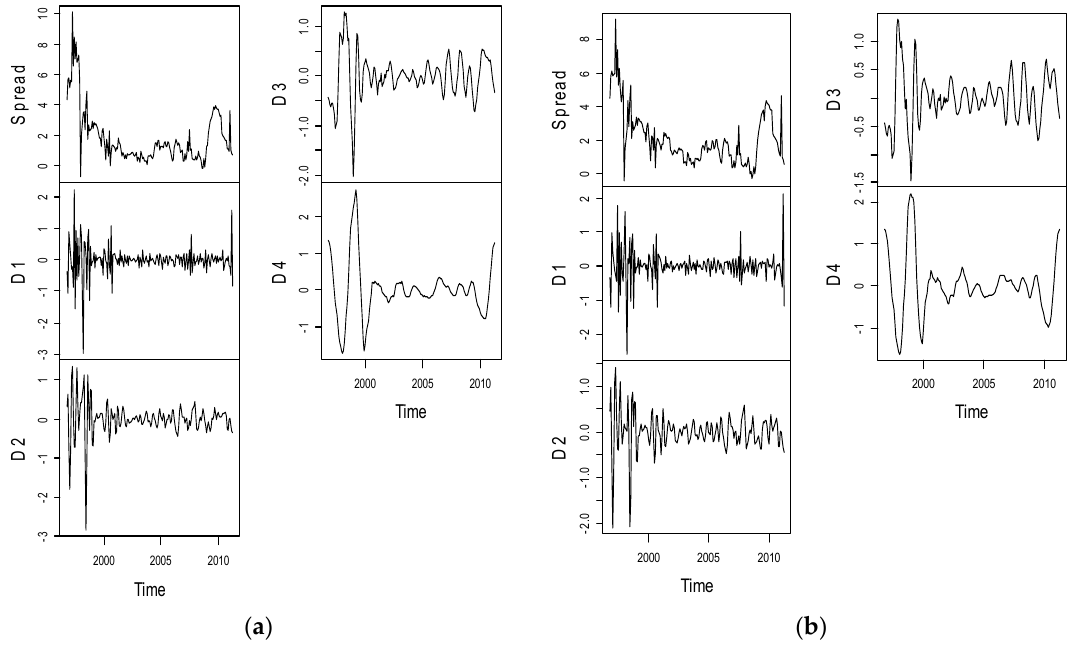
Figure A2. Plot of yield spreads constructed at the policy relevant area of yield curve and their corresponding wavelet decompositions. ( a ) Sp (5, 3); ( b ) Sp (10, 3).